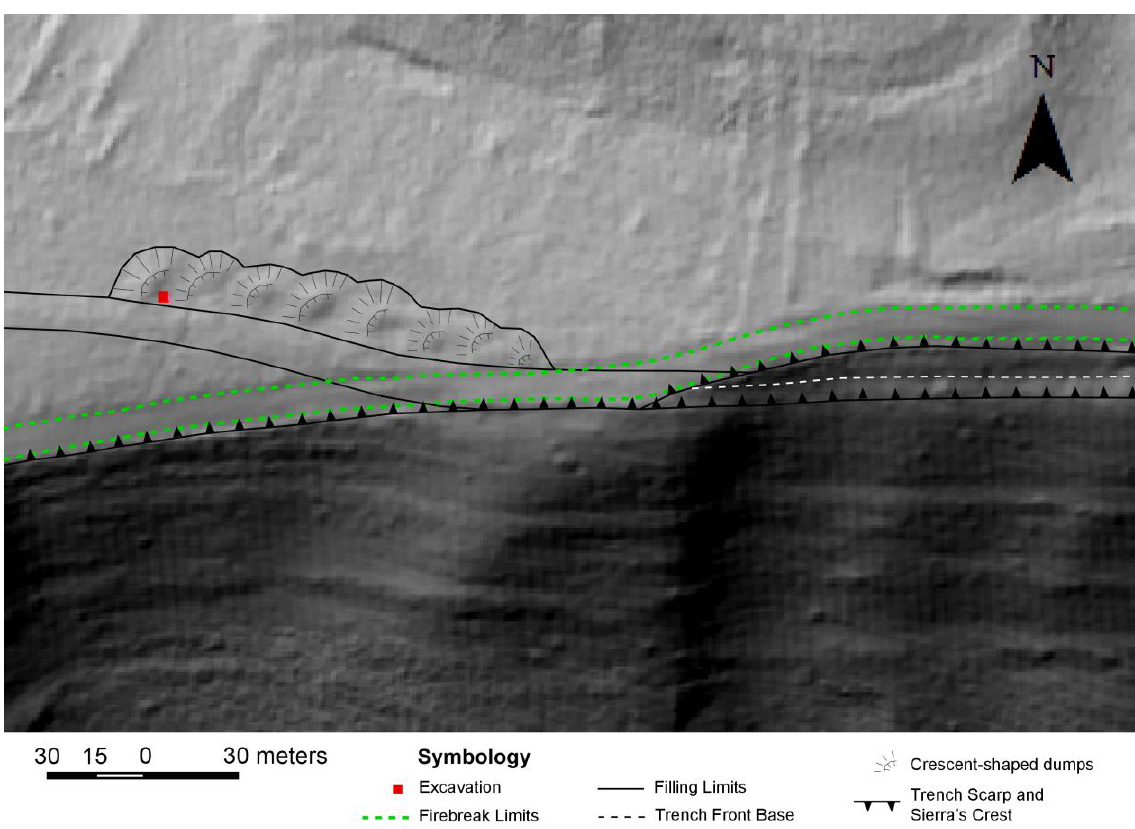
Figure 7. Geomorphological interpretation of mining structures in the excavation area.